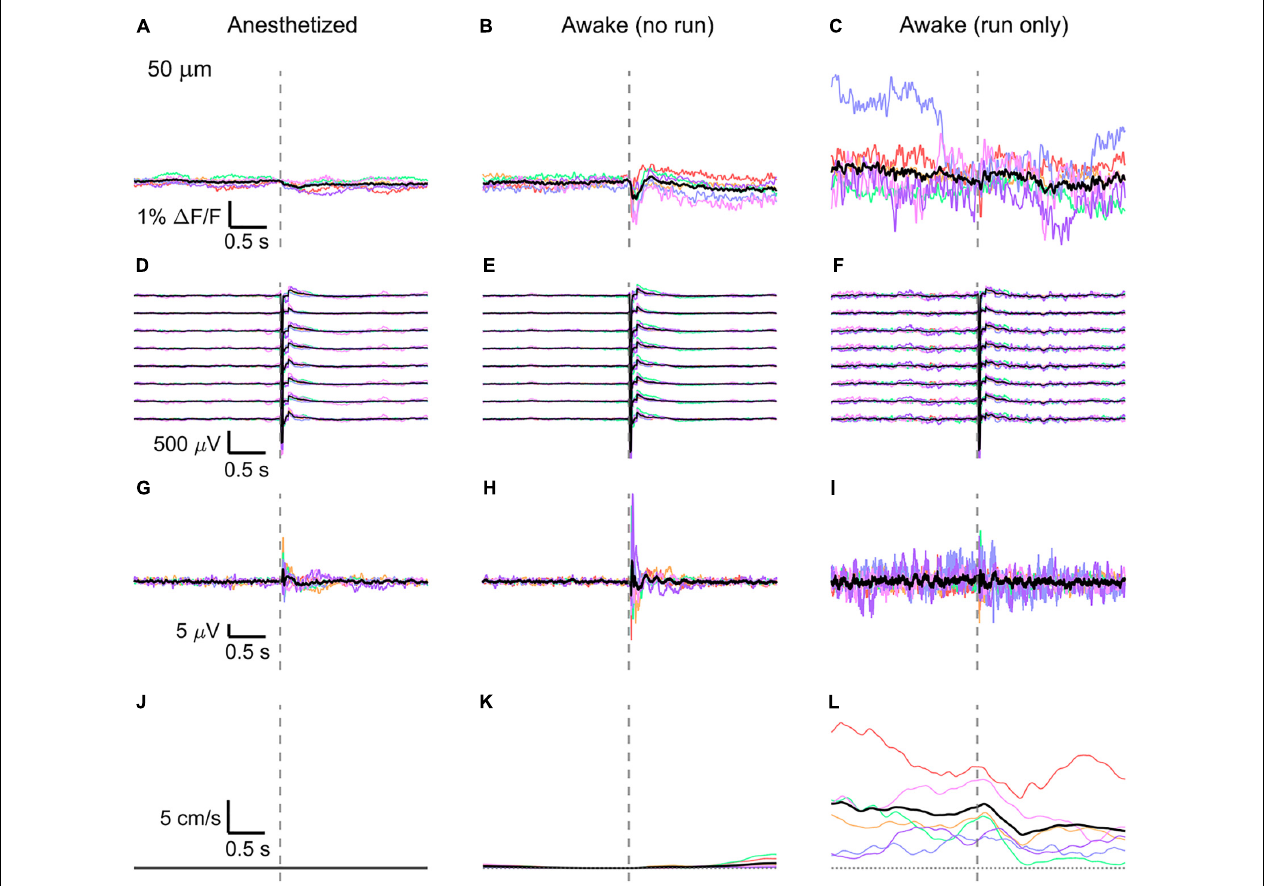
FIGURE 3 | Average VSD signal 50 µ m below dura and LFP, both in barrel cortex, ECoG, and running speed in response to a facial air puff (six mice). Average VSD responses evoked by an air puff to the vibrissae and cheek of the mouse in layer I (50 µ m below dura) recorded in 375 × 24 × 5 µ m 3 and 375 × 12 × 5 µ m 3 box-scans in six mice (A) during anesthesia (133, 187, 139, 139, 126, 134 trials), (B) in awake mice during resting (111, 165, 118, 127, 104, 123 trials), and (C) in awake mice during running (16, 27, 14, 7, 16, 11 trials). (D–F) Corresponding average LFP recorded by eight electrodes (every 4th channel of the linear probe, tip at 850 µ m below dura, bottom LFP trace: 800 µ m, top LFP trace: 100 µ m below dura, (cid:49) depth = 68 µ m between adjacent traces). Corresponding (G–I) average ECoG and (J–L) average speed. Each mouse is indicated by a different color; the overall average is shown in black. Gray dashed line marks the air puff